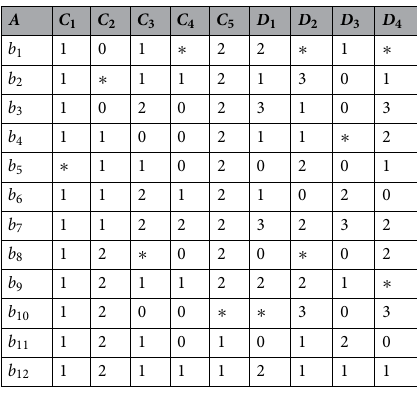
Table 1. Incomplete multi criteria and multi decision information